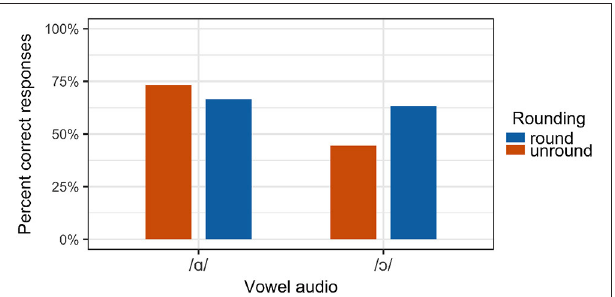
FIGURE 11 | Perception results for all participants.